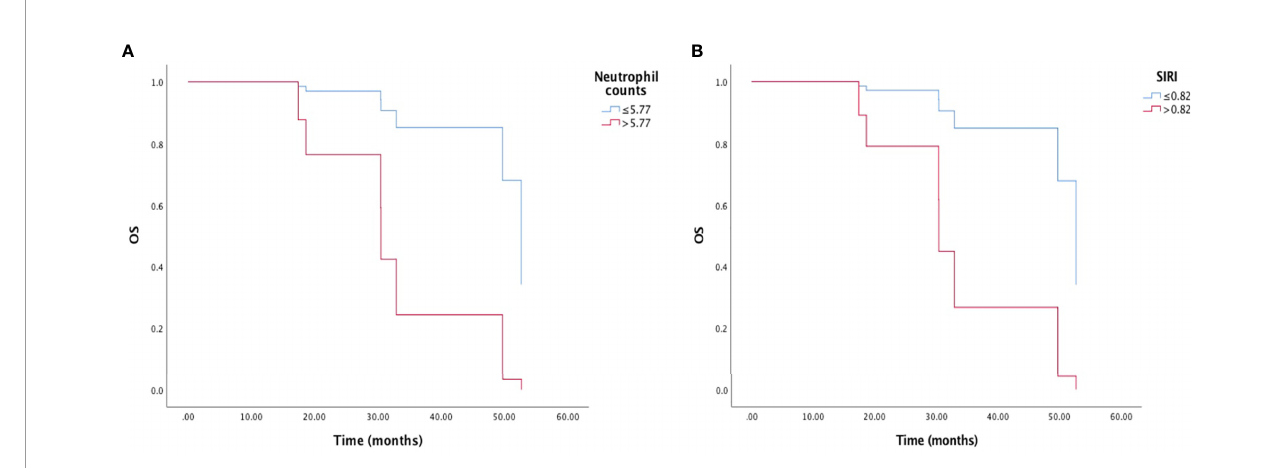
FIGURE 2 | Kaplan-Meier survival curve of overall survival (OS) and (A) neutrophil counts, and (B) in fl ammation response index (SIRI).